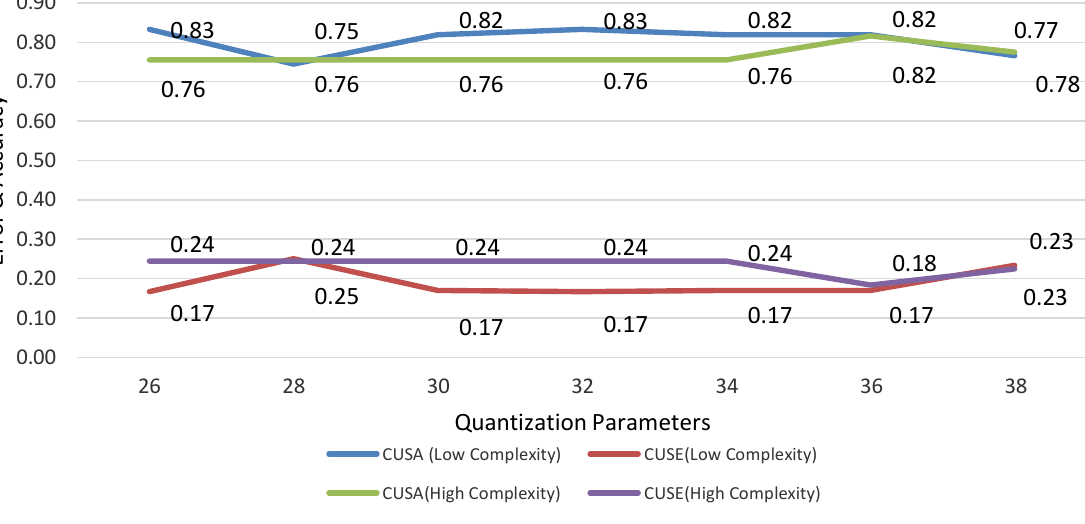
Figure 12. CUS A and CUS E variation based on encoding complexity changes in various QP